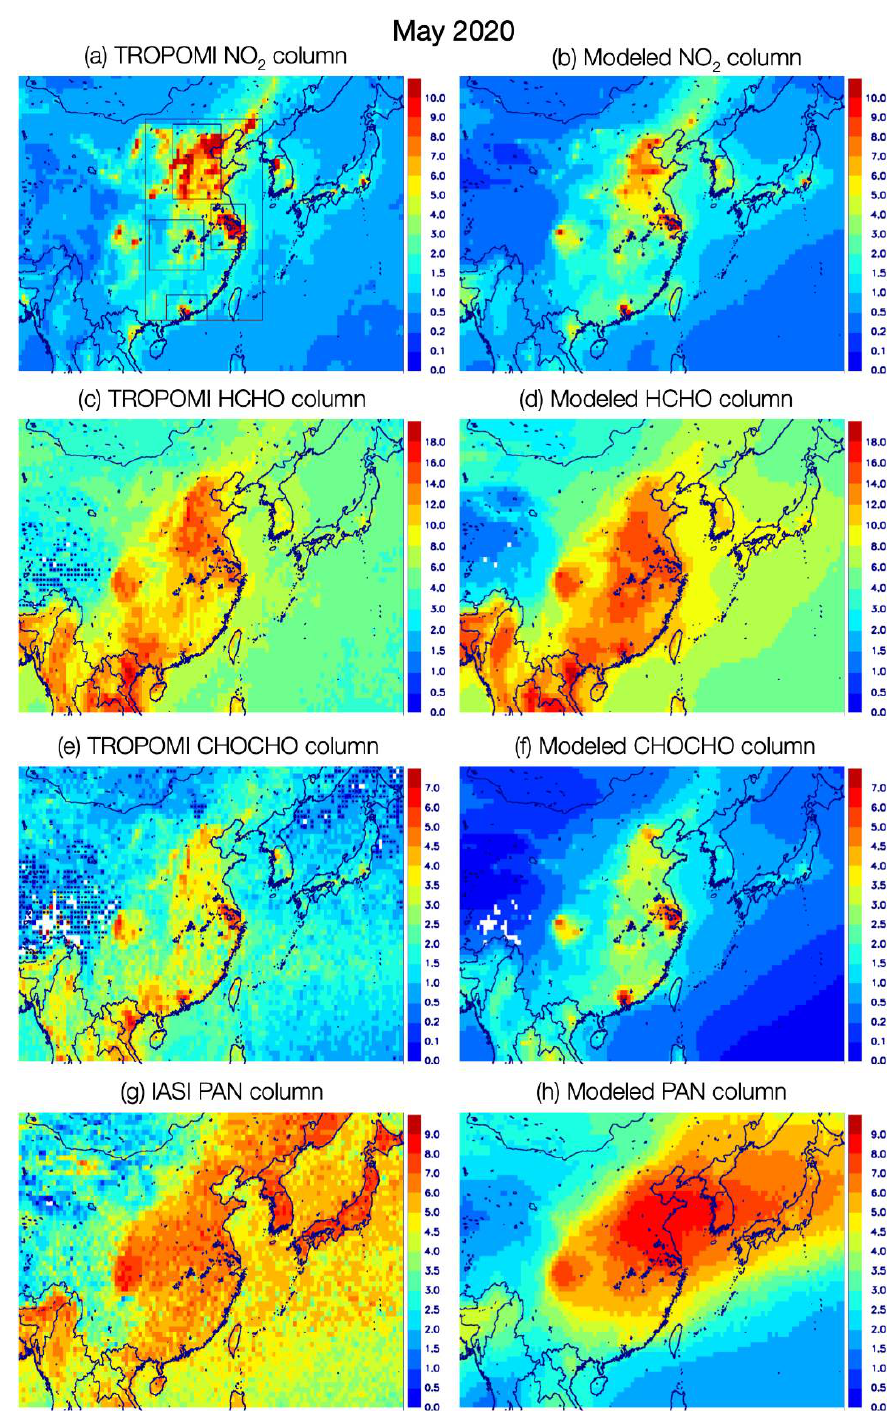
Figure 6. Observed and modeled columns for May 2020. ( a , b ) NO 2 ; ( c , d ) HCHO; ( e , f ) CHOCHO; ( g , h ) PAN. Units are 10 15 molec.cm −2 , except for CHOCHO (10 14 molec.cm −2 ). The stippling in panels c, e, and g indicates data below the estimated detection limit. The boxes of panel ( a ) indicate the analysis regions (also shown on Figure 4).